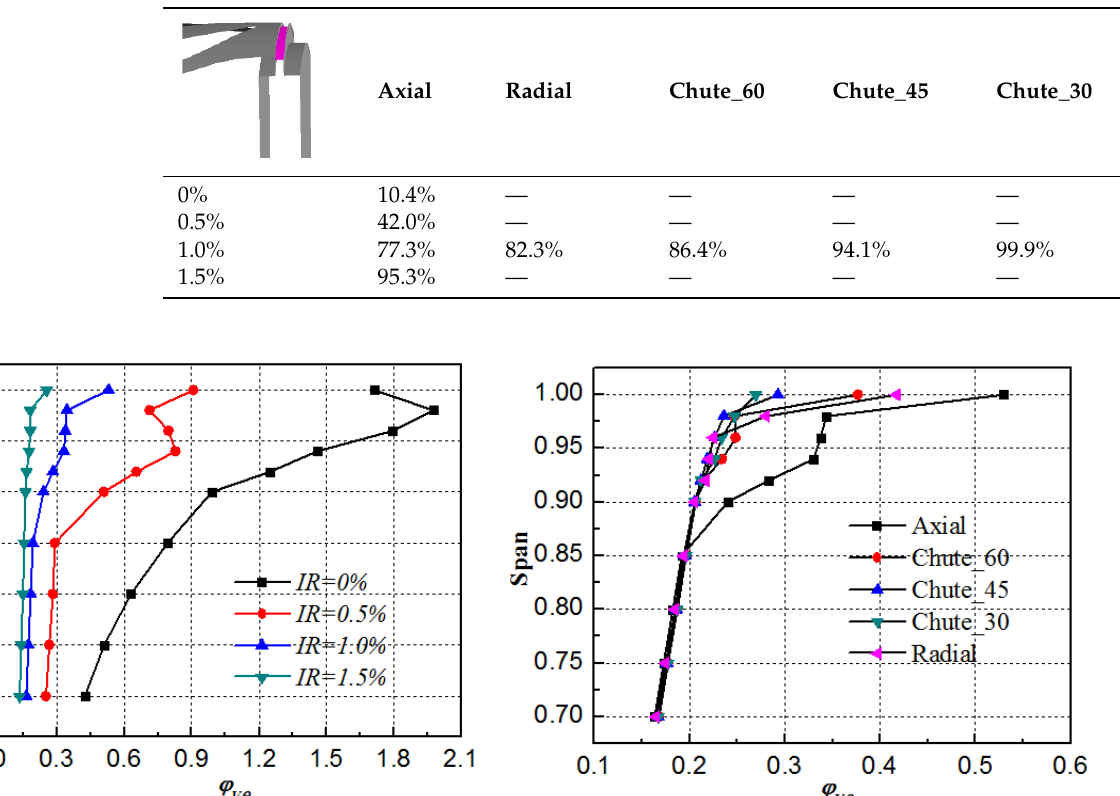
Figure 11. Time-averaged tangential velocity distribution. Table 4. Time-averaged sealing efficiency. Table 4. Time-averaged sealing efficiency.